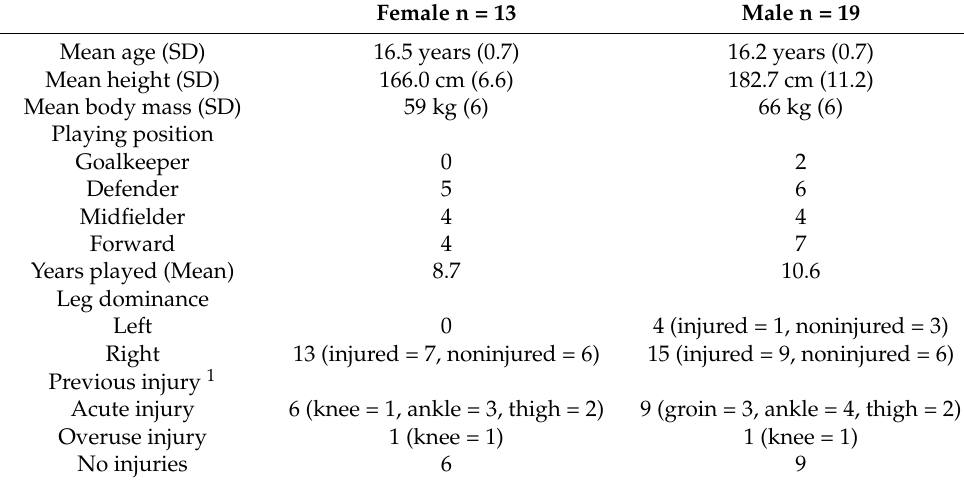
Table 1. Baseline